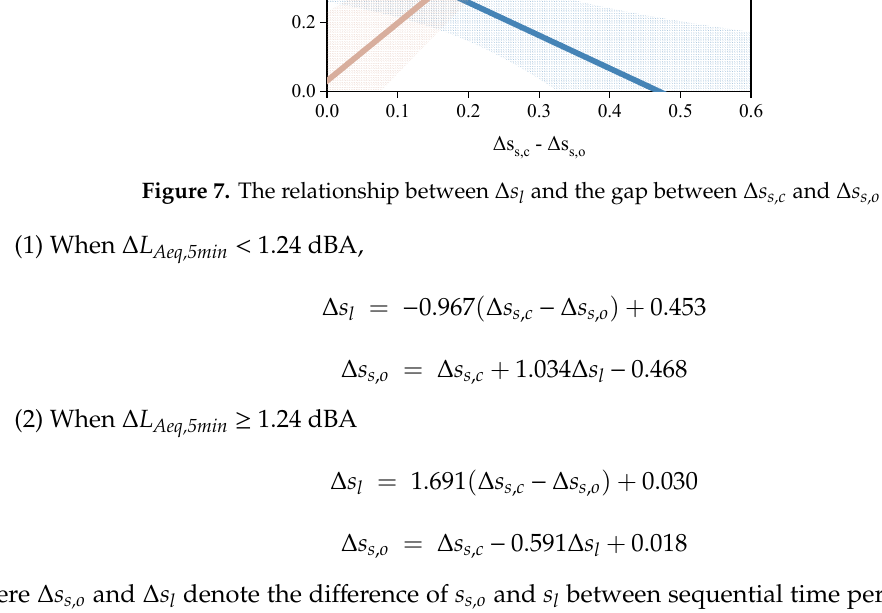
∆ s ∆ s s,c and s,o